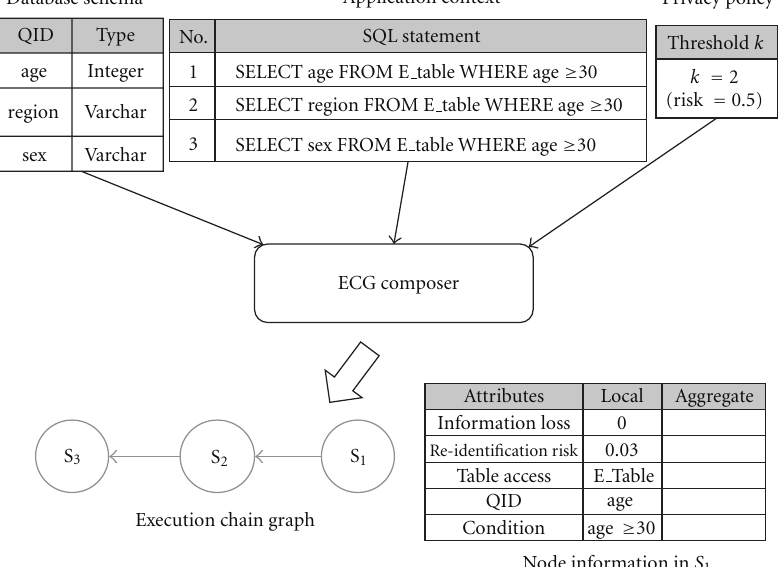
Figure 2: ECG composer